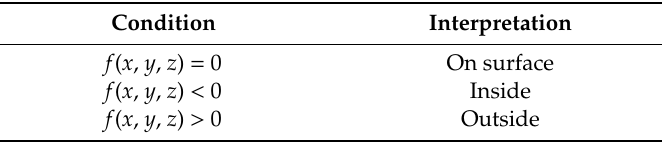
Table 3. Implicit surface in / out convention.